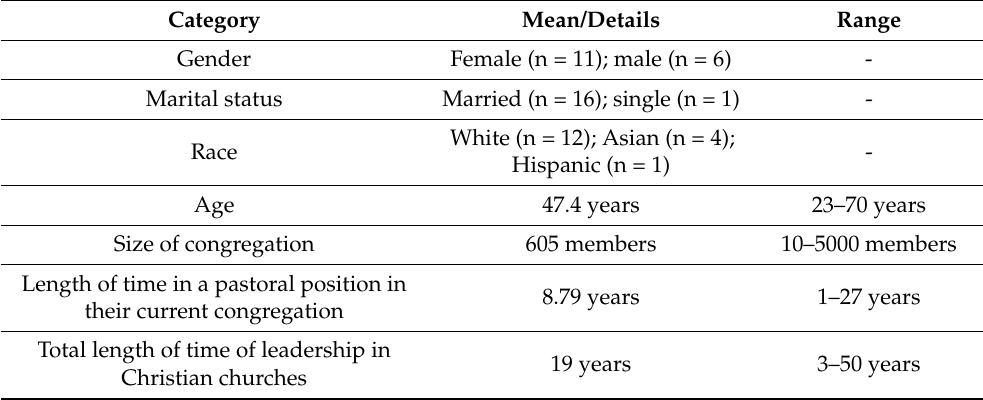
Table 1. Participant and Interview